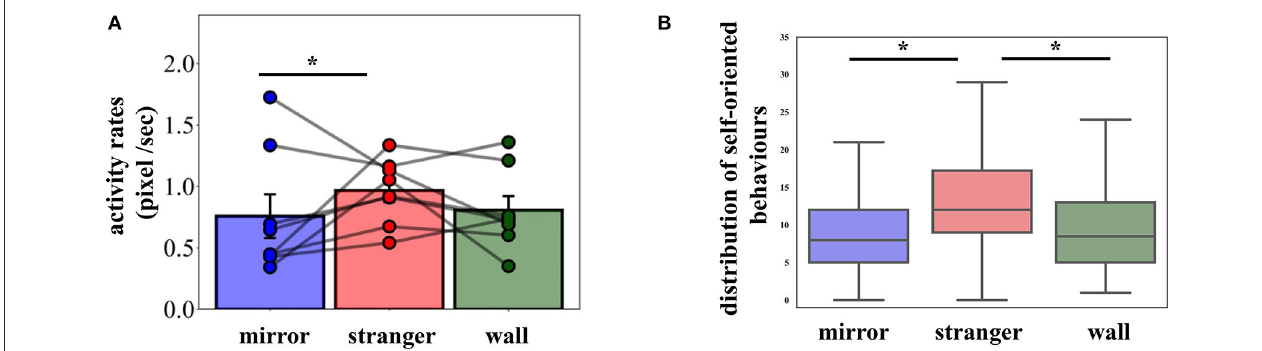
FIGURE 2 | (A) Mean activity rates with the individual data points. Error bars represent SEM. (B) Boxplots of pigeons’ self-oriented behaviors in the experimental conditions (mean values are provided in Table 1 ). Condition had a significant effect on observed behaviors. Pigeons exhibited significantly more behaviors in the Stranger condition compared to the Mirror condition. The whiskers extend to the factor 1.5 of the interquartile range (IQR), with outliers omitted. * p < 0.05.